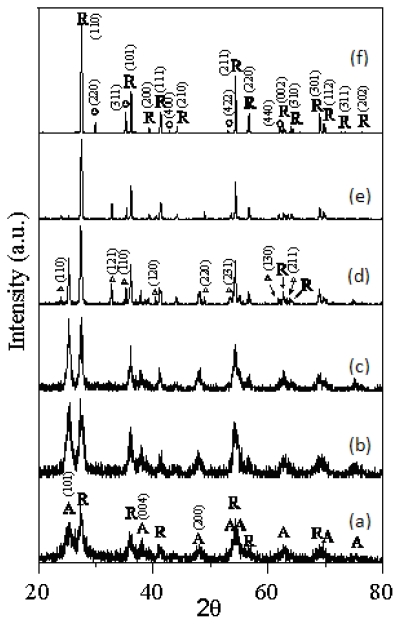
XRD patterns of the T-9Z freeze dried precursor powders are calcined at various temperatures for 2 h: (a) 523 K; (b) 673 K; (c) 773 K; (d) 873 K; (e) 973 K and (f) 1273 K (A: anatase; R: rutile; Δ: Zn2Ti3O8; ○: Zn2TiO4).